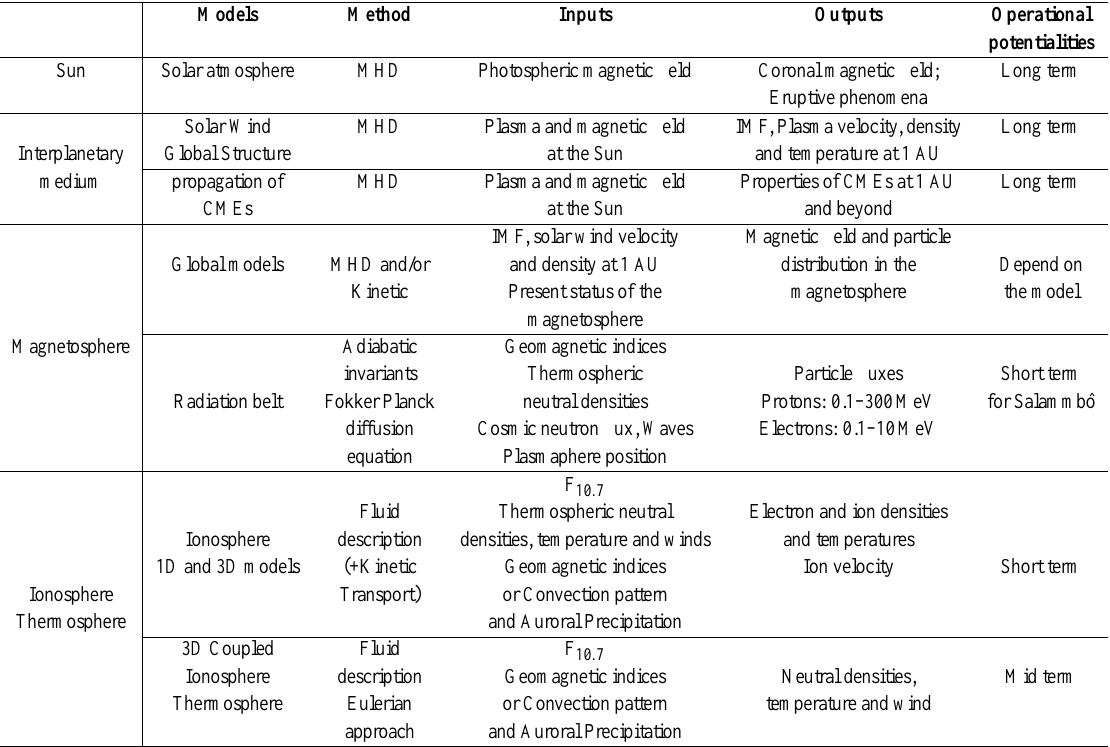
Table 3. Summary of non-operational physical model classes. The last column states their operational potentialities as foreseen today, if resources are available for operational